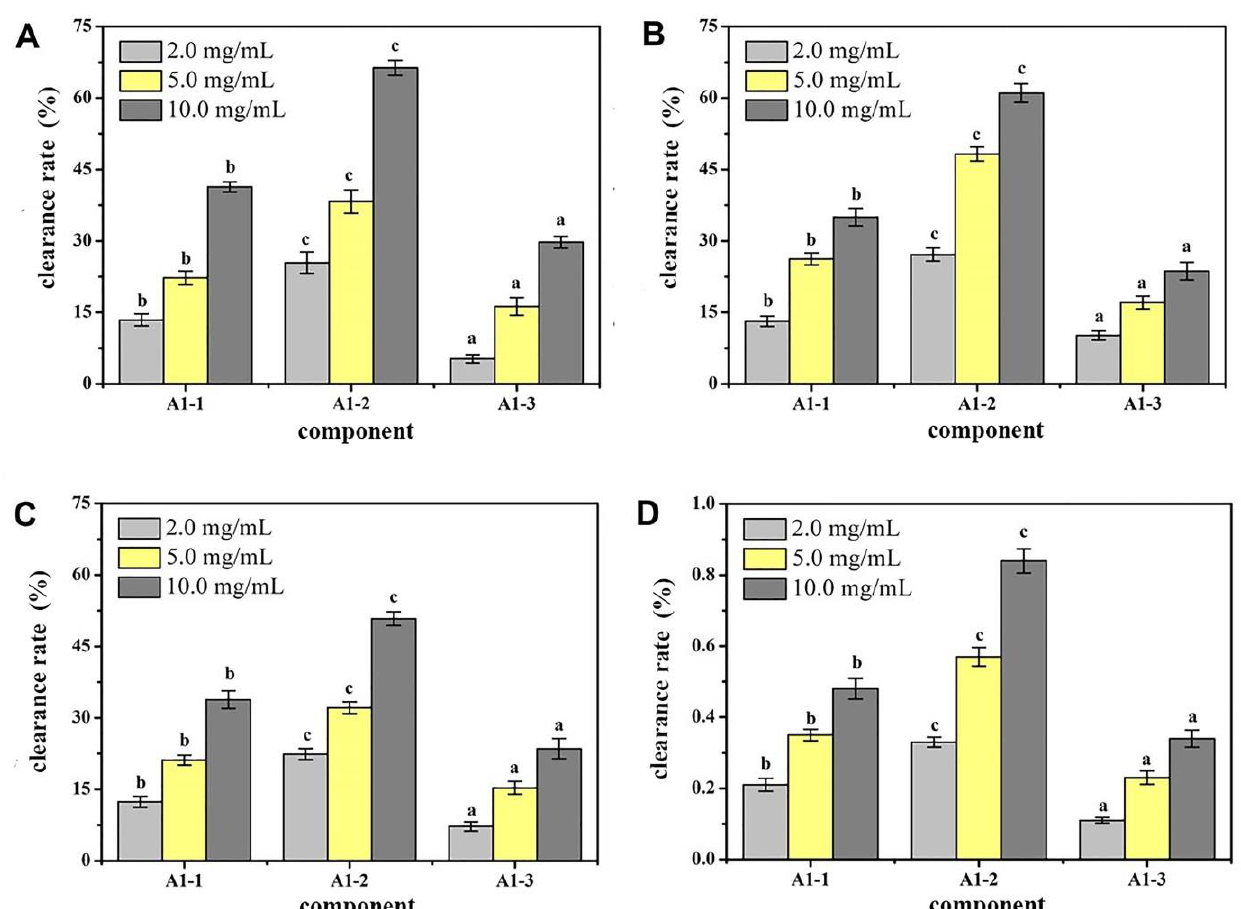
Figure 4. Antioxidant activity of different peptides fractions A1-1, A1-2 and A1-3 from Camella vietnamensis in vitro. (Note: ( A ) was the scavenging effect on DPPH, ( B ) was the scavenging effect on · OH, ( C ) was the total reducing power, and ( D ) was the scavenging effect on superoxide